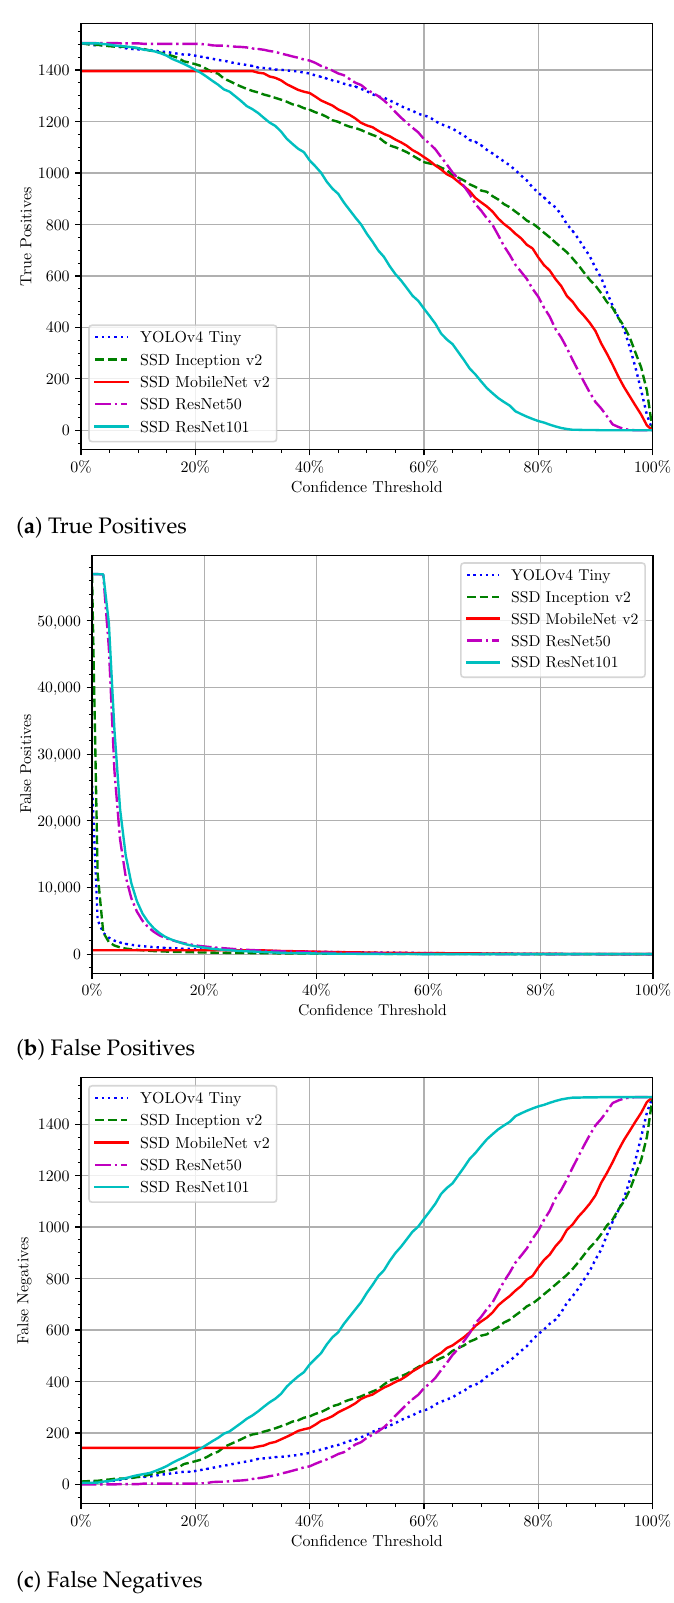
Figure 10. Evolution of the number of TPs, FPs, and FNs with the increase of the confidence